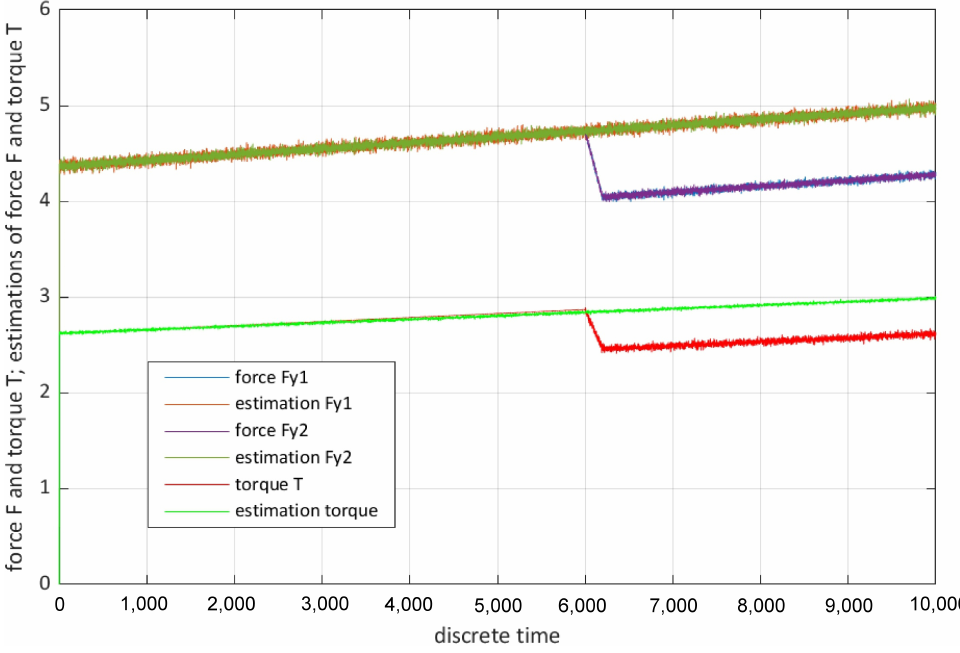
Figure 6. Exemplary estimation result; fault at k = 6000 s.